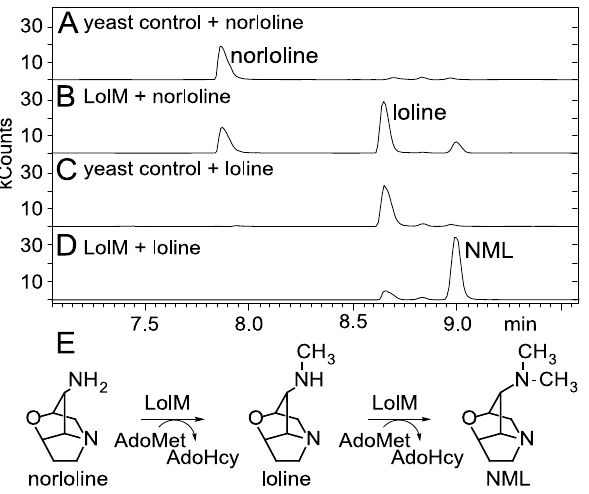
Fig. 6. Assay of LolM methyltransferase activity. (A) Chromatogram of loline alkaloids from incubation of norloline and AdoMet with protein extract of yeast transformed with empty vector. (B) Chromatogram of loline alkaloids from incubation of norloline and AdoMet with crude protein extract from yeast that expresses LolM. (C) Chromatogram of loline alkaloids from incubation of loline and AdoMet with protein extract of yeast transformed with empty vector. (D) Chromatogram of loline alkaloids from incubation of loline and AdoMet with crude protein extract from yeast that expresses LolM. (E) Proposed scheme of loline and N -methylloline (NML) formation from norloline. AdoHcy 5 S -adenosyl homocysteine.